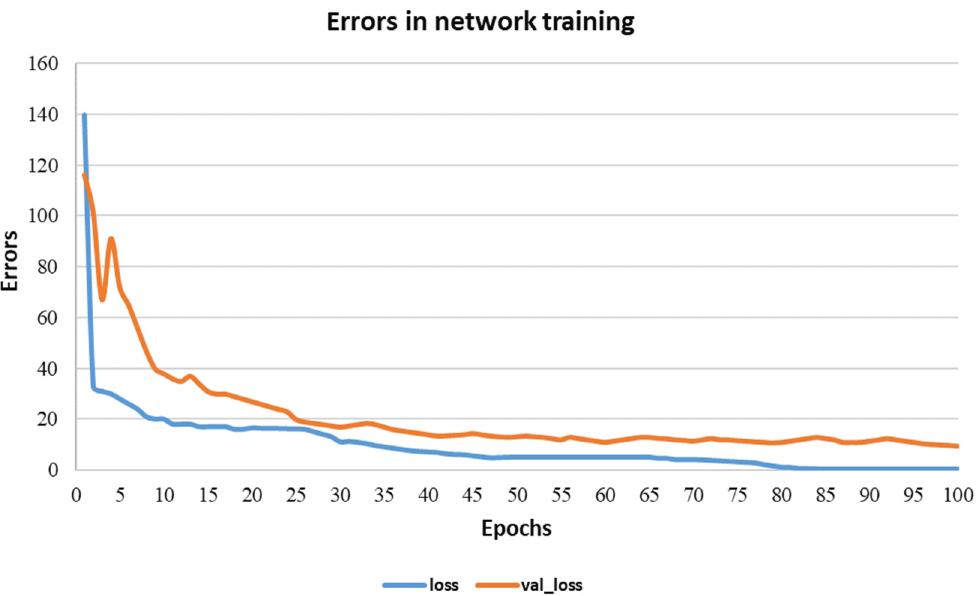
Figure 8. The training processes of the proposed model. Training loss and validation loss during network training.